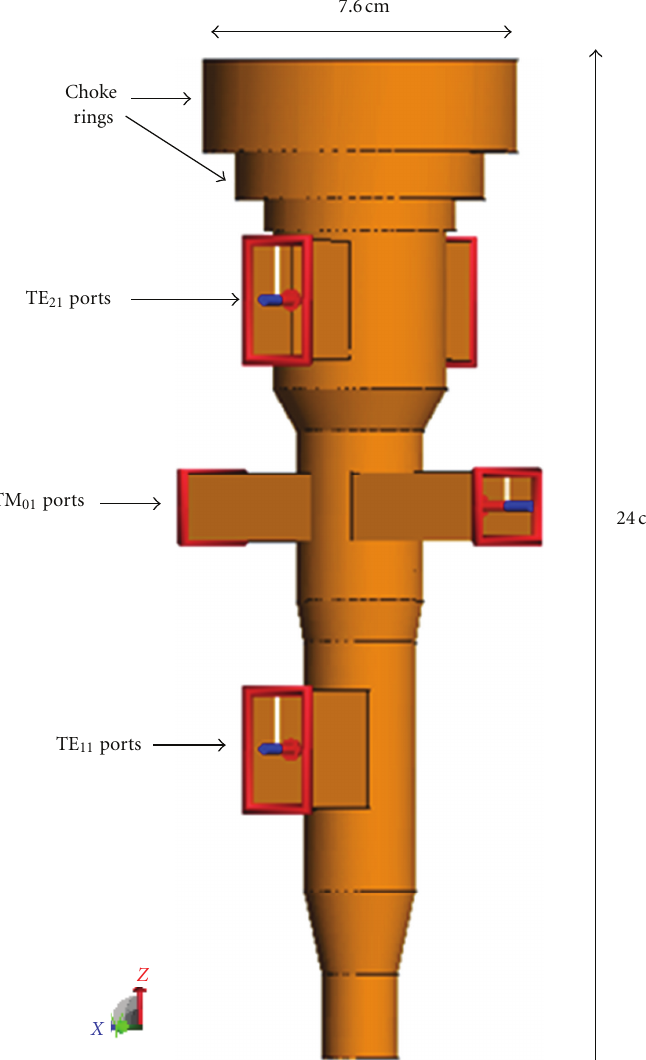
Figure 1: Geometry of the triple-mode feedhorn designed using